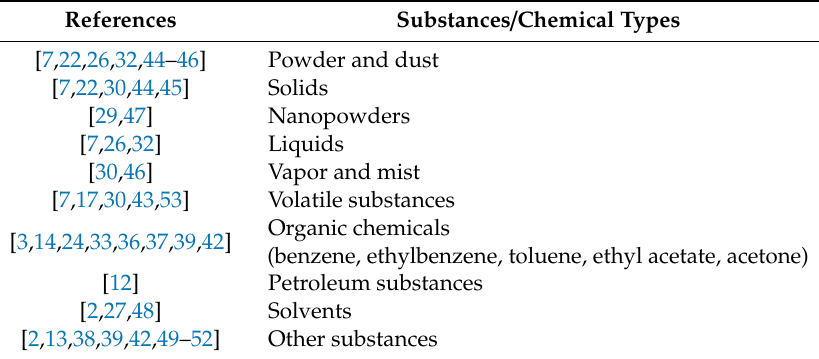
Table 4. Summary of chemicals considered in di ff erent studies.